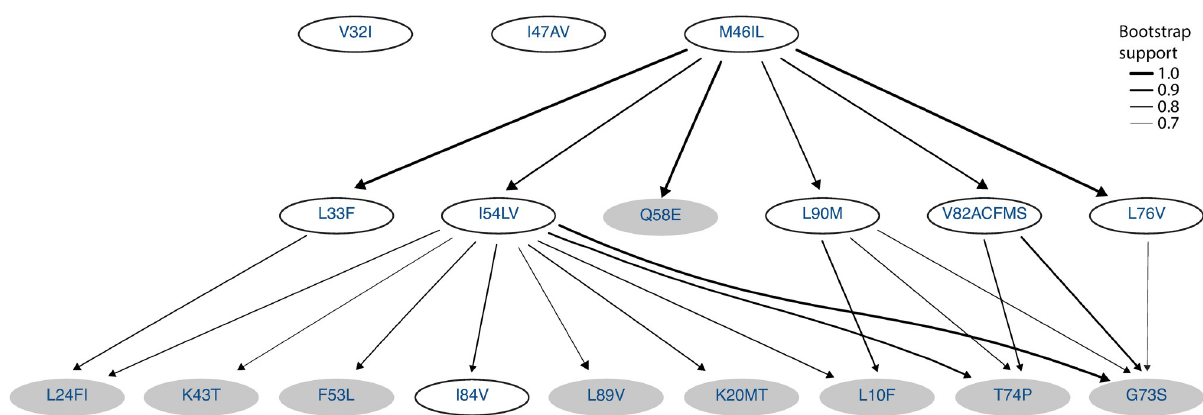
Fig 4. Consensus poset for the accumulation of mutations in HIV-1 subtype B under lopinavir treatment. The underlying data set contains 470 genotypes retrieved from the HIVDB and SHCS. Nodes in the network correspond to amino acid changes in the HIV-1 protease, and mutations at the same locus are grouped together. Edge labels indicate the bootstrap support, and we show only edges with a bootstrap support greater or equal to 0.7.